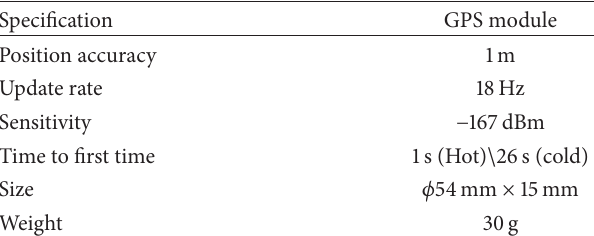
Table 3: Specifications of GPS module.